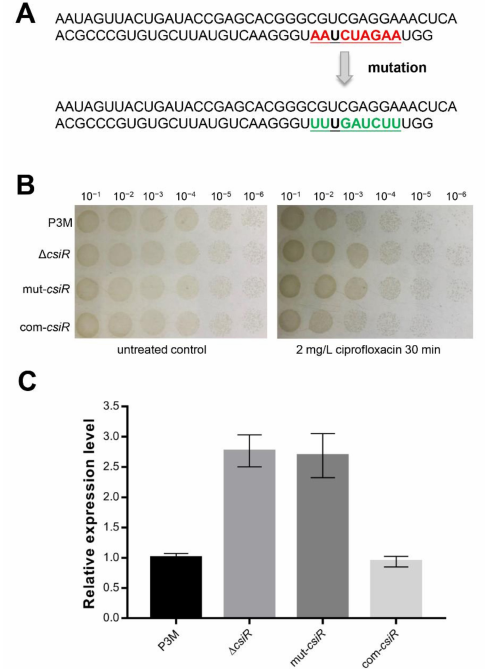
Figure 6. In vivo validation of the binding sites of CsiR. ( A ) Schematic diagram of the binding sites mutation of CsiR. ( B ) Spot growth assays of wild-type P3M, csiR deletion mutant strain ( ∆ csiR ), csiR complemented stain with mutations (mut- csiR ), and csiR complemented strain (com- emrB ) with or without the treatment of ciprofloxacin. ( C ) Relative mRNA expression levels of emrB in different backgrounds. Data were obtained from three independent repeated tests. Survival and expression data were obtained from three independent repeated tests ( n =